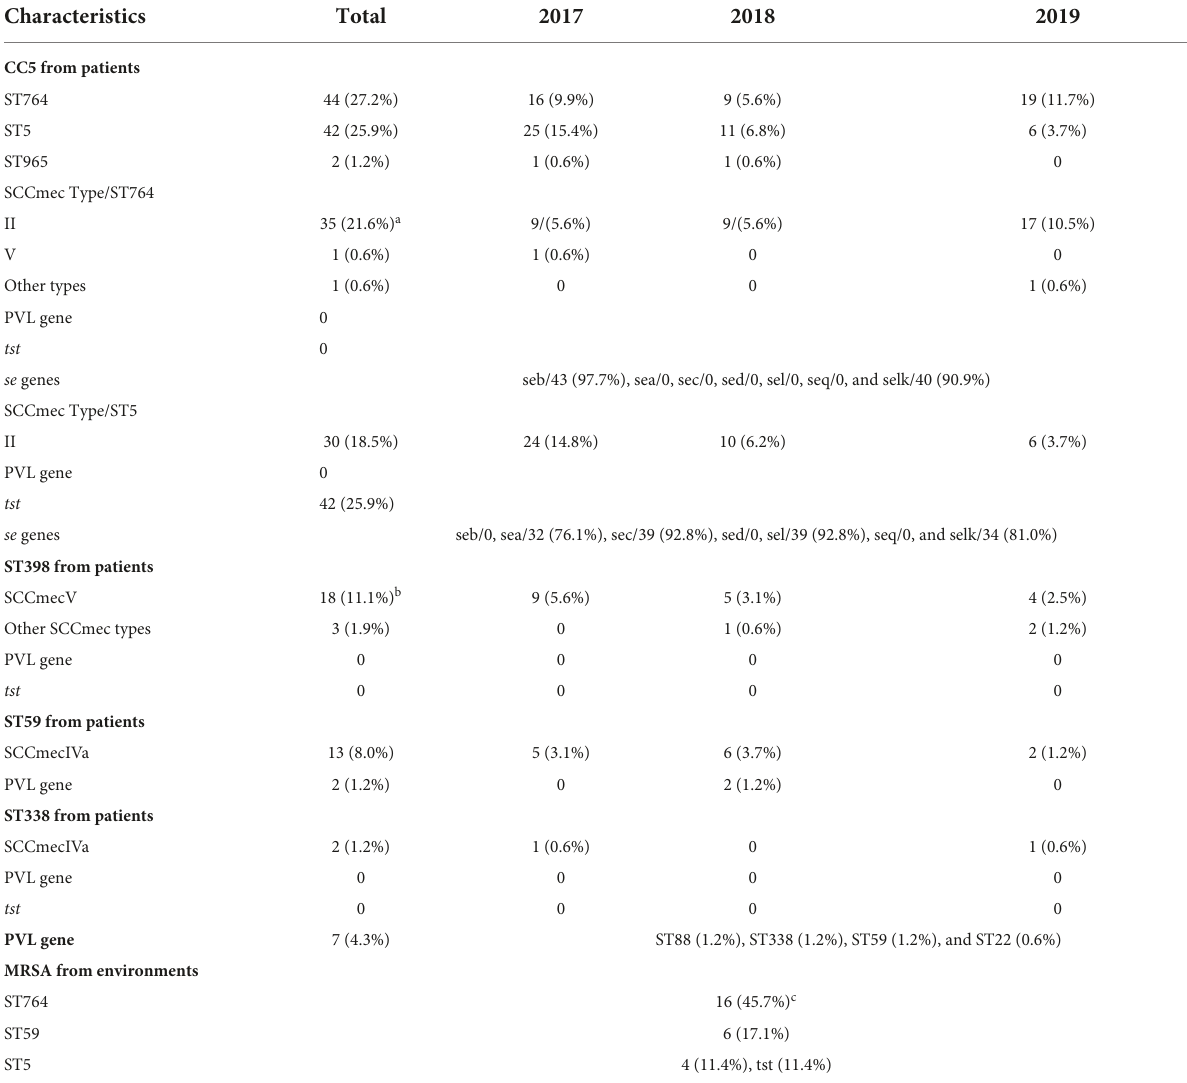
TABLE 2 Genetic characteristics of methicillin-resistant Staphylococcus aureus (MRSA) isolates during 2017–2019 in Shanghai, China.